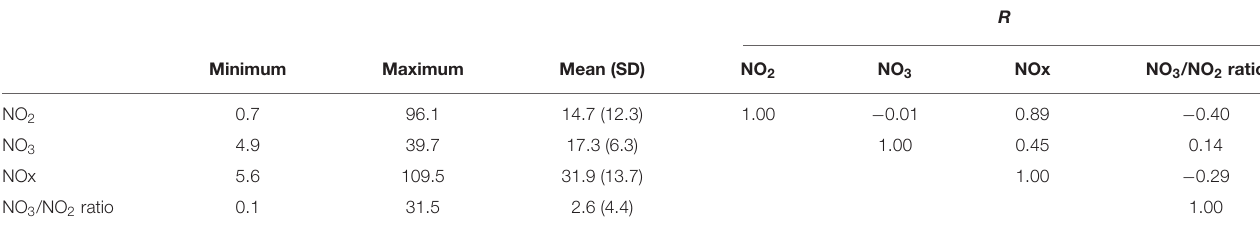
FIGURE 2 | High-performance liquid chromatography (HPLC)-UV chromatogram. The peak located at 10.2 min was identified as nitrite (NO 2 ), while the peak at 31.6 min was identified as nitrate (NO 3 ). The peak areas of each compound in the standard solutions were used for the calculation of the calibration curve, from which the concentrations in follicular fluid samples (e.g., samples 1 and 2) were obtained. TABLE 2 | Follicular fluid levels of nitrite (NO 2 ), nitrate (NO 3 ), total nitric oxide (NOx), NO 3 /NO 2 ratio, and Pearson correlation coefficients between these